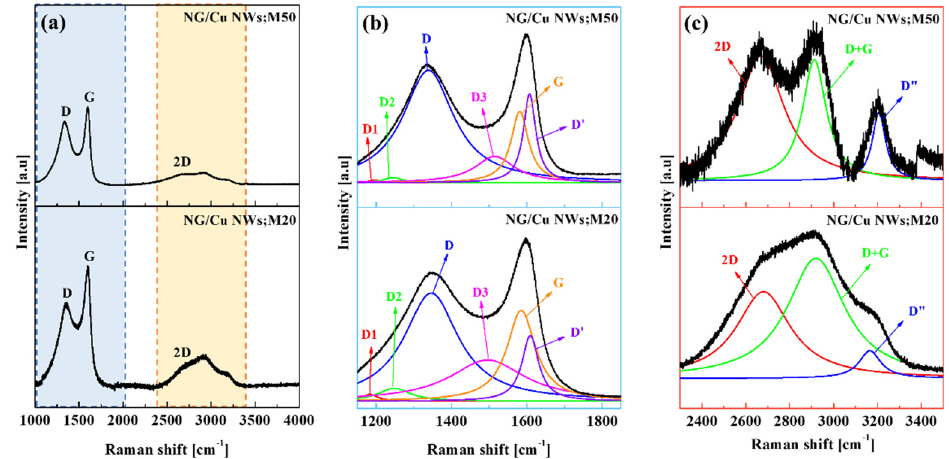
Figure 3. Raman spectra ranging from ( a ) 1000–4000 cm − 1 , ( b ) 1100–1900 cm − 1 , and ( c ) 2300–3500 cm − 1 .